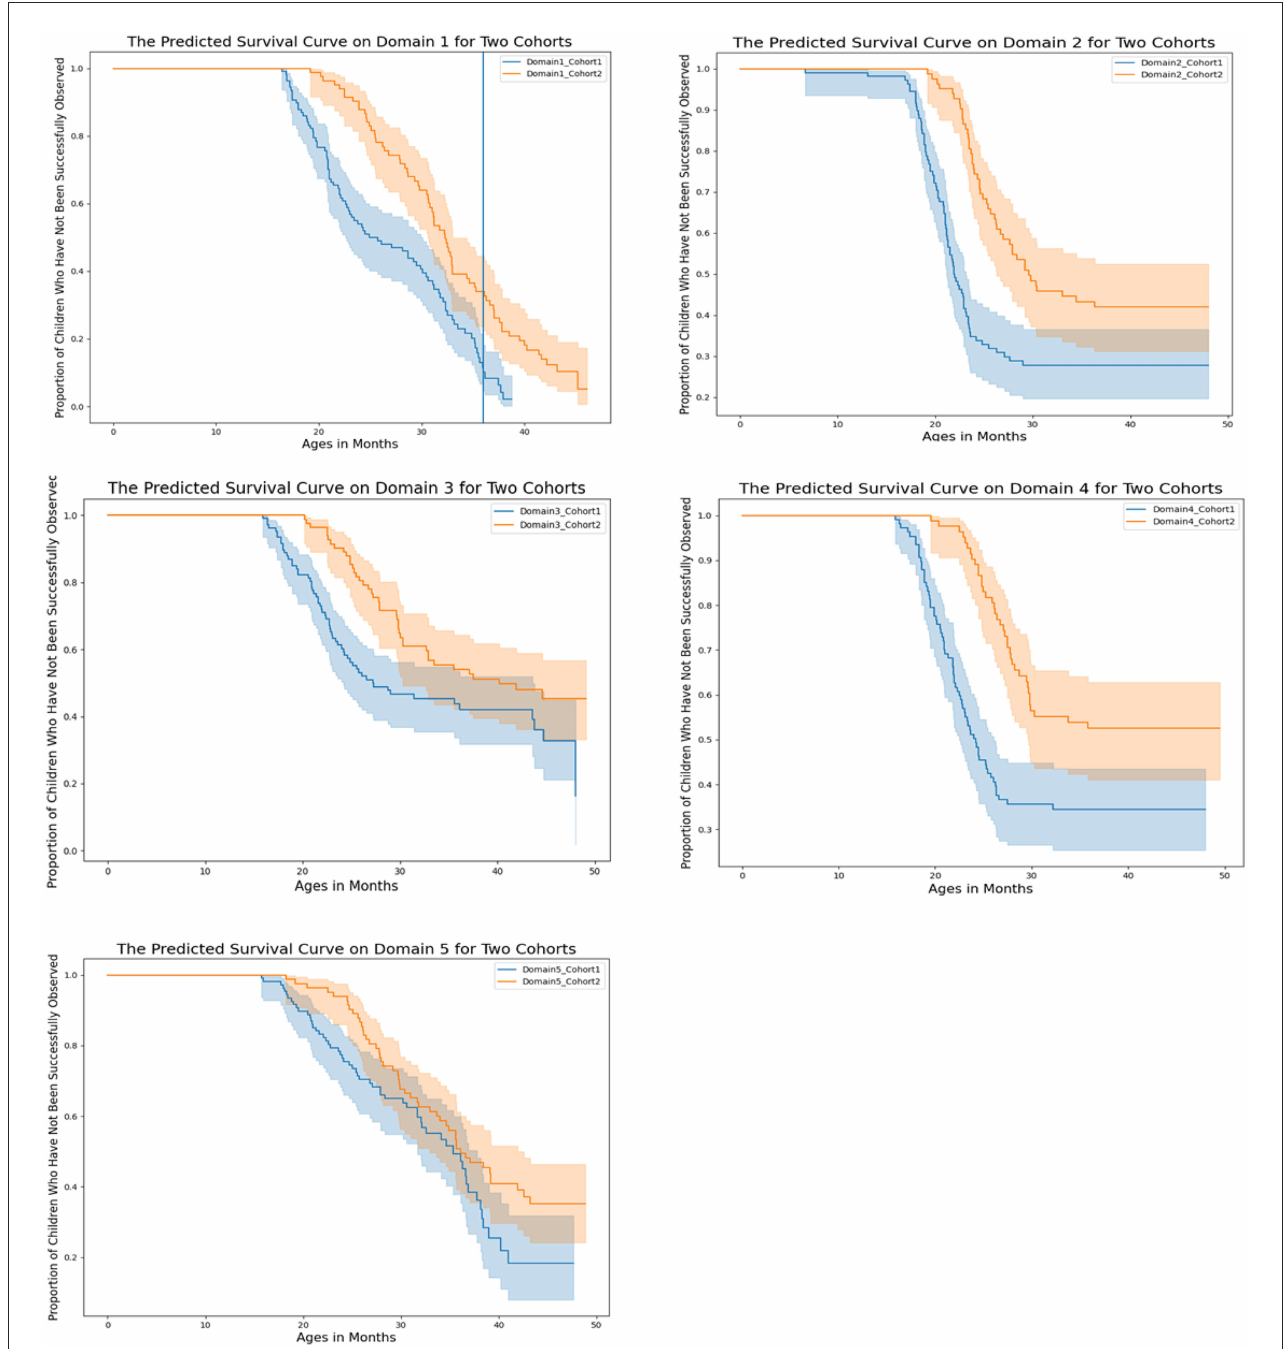
FIGURE3 The predicted survival curves with Cox Proportional-Hazards Model on five domains for two cohorts.